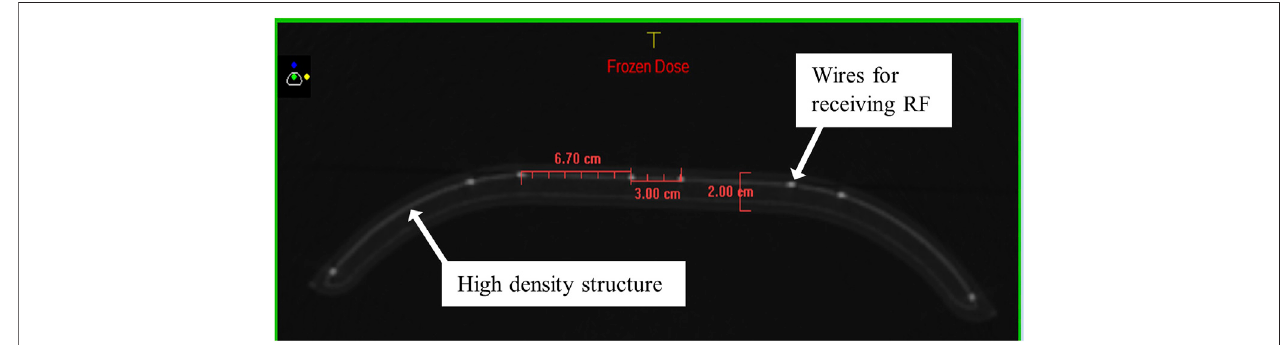
FIGURE 3 | Internal structure of the coil as from a CT of the device, showing the high-density substructure housing the RF receiver wires and providing structural support. Distances between the wires and the coil thickness are shown in